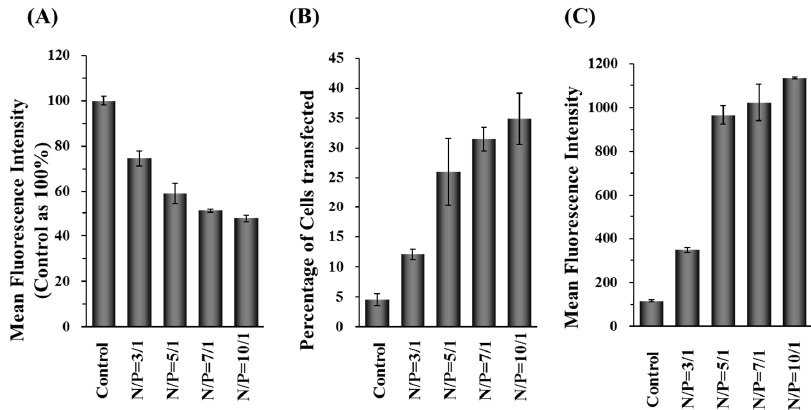
Figure 3. The siRNA silencing effects and transgene (DsRed) expressions of Hep 3B cells after transfected